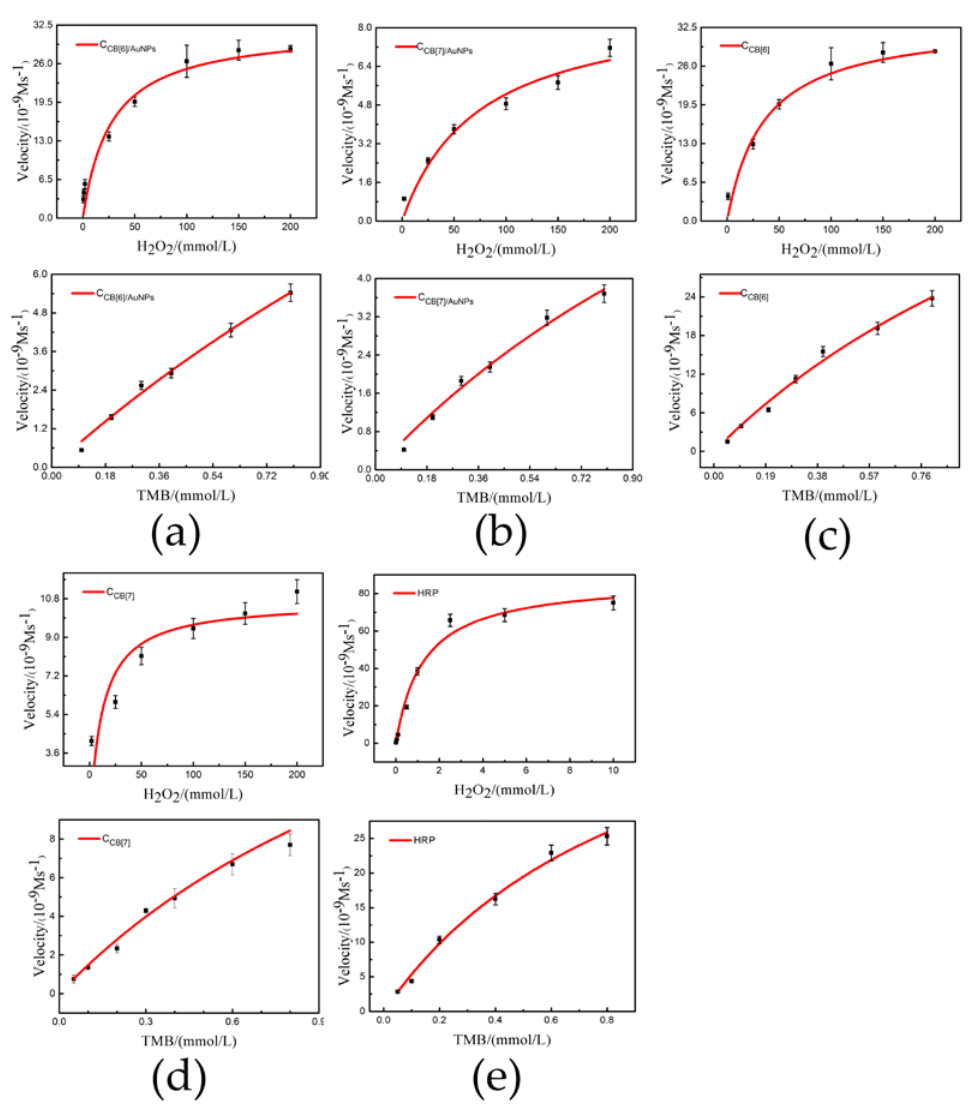
Figure 6. Steady-state kinetic curves of different materials in this work and HRP: ( a ) C CB[6]/AuNPs ; ( b ) C CB[7]/AuNPs ; ( c ) C CB[6] ; ( d ) C CB[7] ; ( e ) HRP.